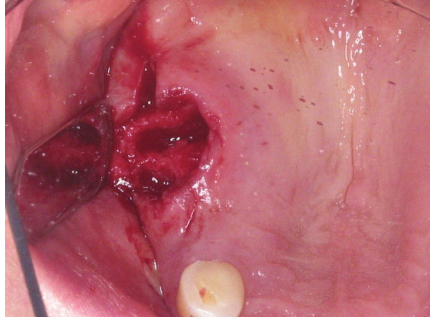
Figure 1: Initial presentation.